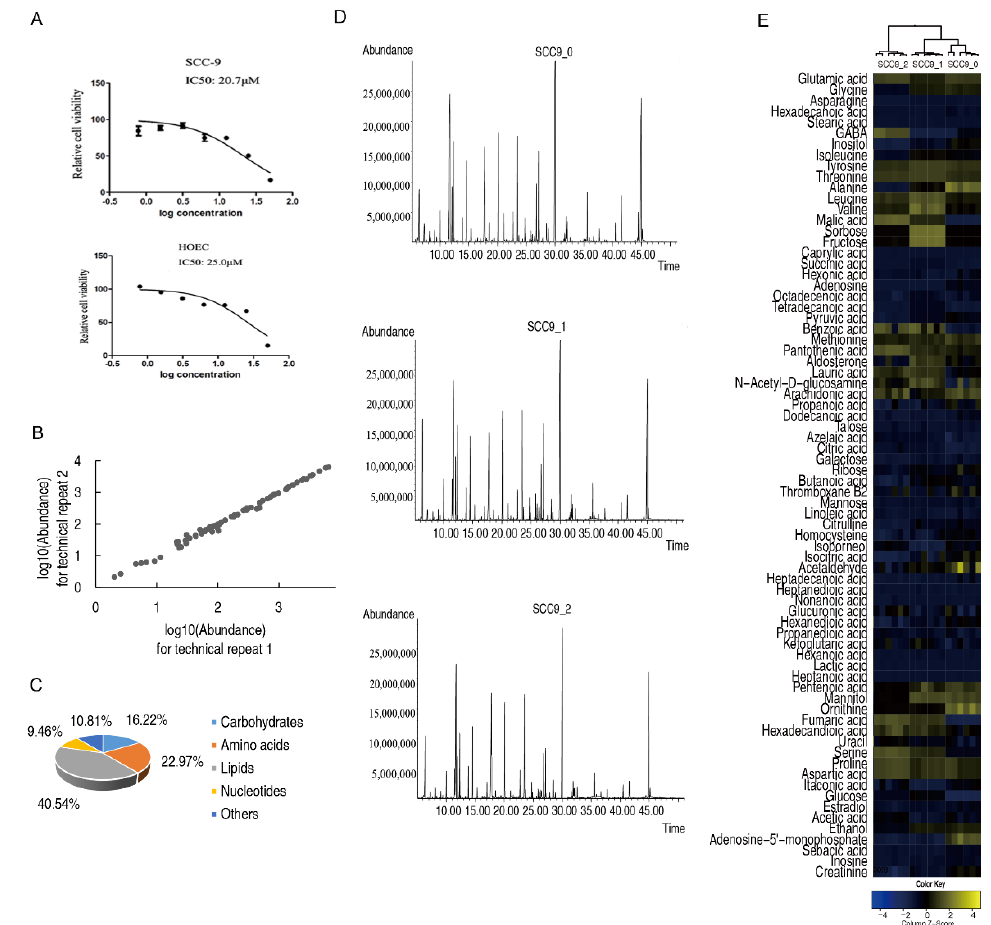
Figure 1. Metabolomics profiles of SCC-9 cells. Measurements of IC 50 of SCC-9 and HOEC cells ( A ). Reproducibility of the metabolomics profiling platform ( B ). Classification of metabolites ( C ). Representative total ion current chromatograms ( D ). Cluster analysis of all metabolites ( E ). SCC9_0, SCC9_1 and SCC9_2 represent the SCC-9 cells treated with cisplatin for 0 h, 24 h or 48 h.